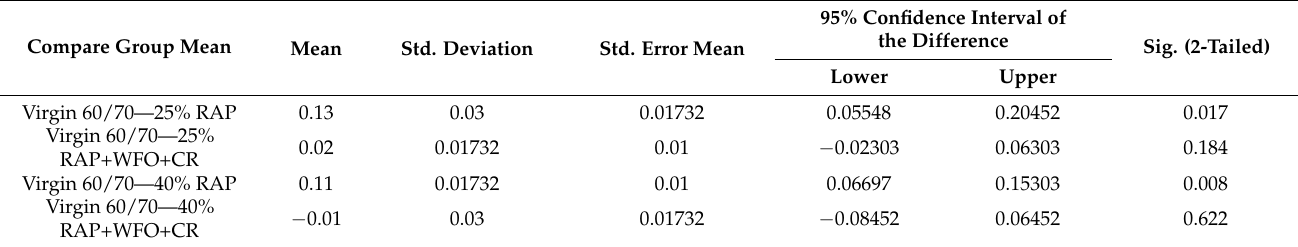
Table 11. Comparison of significant difference of group means for the loss on the heating result.